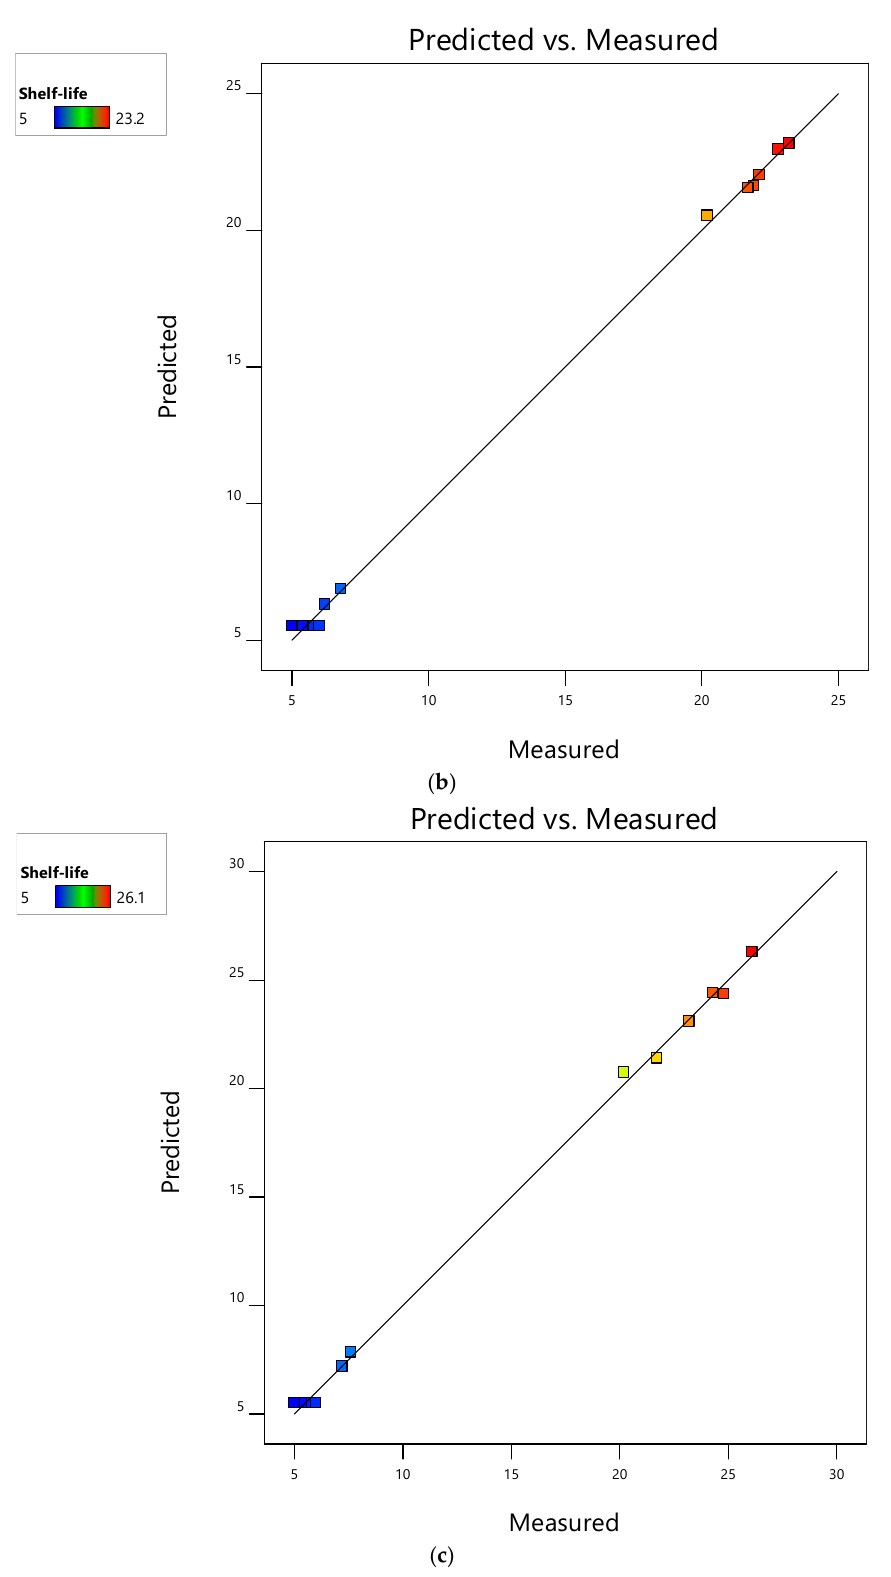
Figure 4. Measured vs. predicted bi-plots for shelf-life extension of mushrooms stored at 4 ◦ C: ( a ) M 1 (mushrooms of WS and OLPR mixtures); ( b ) M 2 (mushrooms of WS and SCG mixtures); and ( c ) M 3 (mushrooms of WS and OLPR/SCG